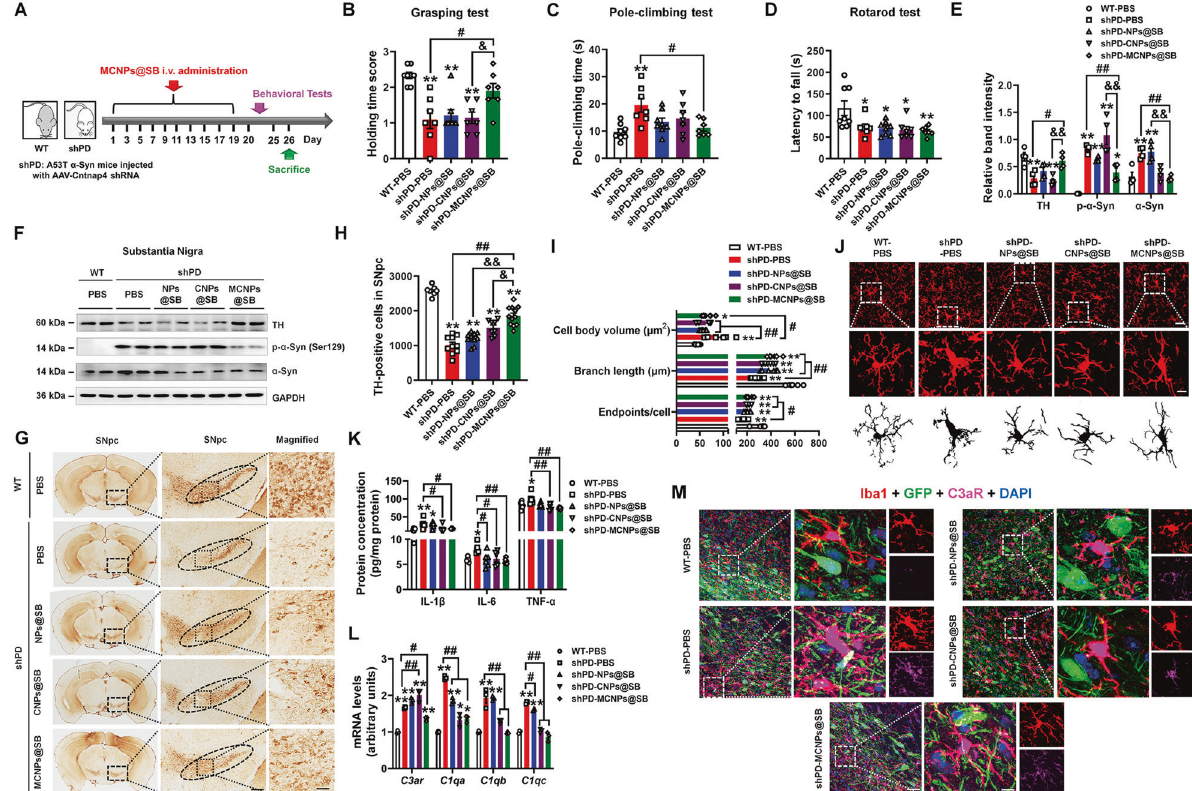
Fig. 8 Microglial delivery of C3aR antagonist improves the parkinsonian phenotype in A53T α -Syn mice injected with AAV-Cntnap4 shRNA. A Schematic model of the study design. B The grasping test was used to examine the grip strength of mice. C The pole-climbing test was used to examine bradykinesia in the mice. D The rotarod test was used to examine the motor coordination of mice; n = 7 – 8. E , F The protein expression levels of TH, phosphorylation of α -synuclein at serine 129, and mouse α -synuclein in the SN were determined by western blotting; n = 3 per group. G , H Immunohistochemical staining and quanti fi cation of TH-positive cells in the SNpc. Scale bars: 100 μ m. Magni fi ed images are shown in the right column. Scale bars: 50 μ m; n = 8 – 12. I , J Immuno fl uorescence staining and quanti fi cation of Iba1- positive cells in the SNpc. Scale bars: 30 μ m. Magni fi ed images are shown in the middle column, and skeletal diagrams of Iba1-positive cells are shown in the bottom panel. Scale bars: 8.5 μ m; n = 6 – 7. K The protein expression of nigral Il-1 β , IL-6, and TNF- α ; n = 6 per group. L The mRNA expression levels of nigral C3ar , C1qa , C1qb , and C1qc were determined by qRT-PCR; n = 3 per group. M Co-staining and quanti fi cation of Iba1 with C3aR in the SNpc. Scale bars: 40 μ m. Magni fi ed images are shown in the right column of panel ( M ). Scale bars: 8 μ m. Results are expressed as the mean ± SEM. ** p < 0.01, * p < 0.05 vs . WT; ## p < 0.01, # p < 0.05 vs. shPD; && p < 0.01, & p < 0.05 vs. shPD-MCNPs@SB. Statistical signi fi cance was determined using one-way ANOVA + Tukey ’ s multiple comparisons